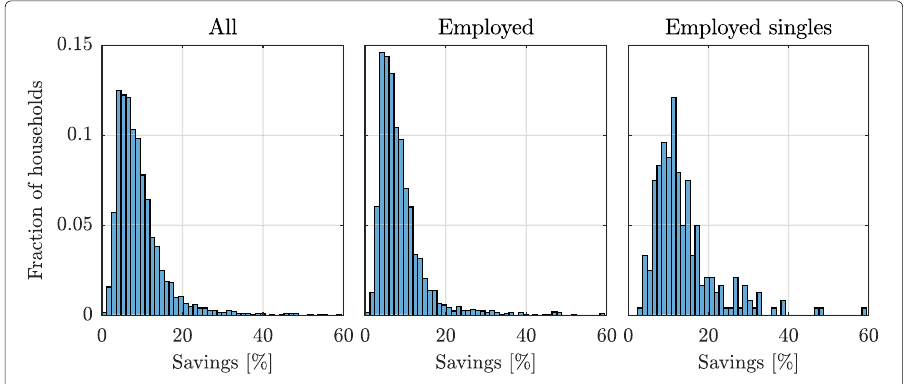
Fig. 5 Histograms of the relative savings for the oracle